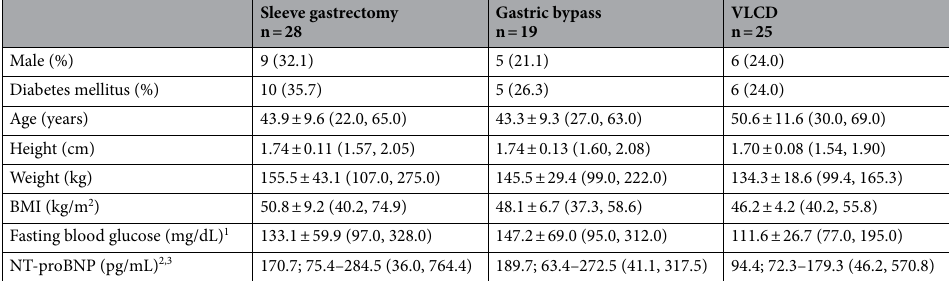
In the same 26-week period, NT-proBNP concentration increased by a median of 44.3 pg/mL from 170.7 pg/ mL (75.4–284.5) to 203.9 pg/mL (136.0–378.8) in the group receiving sleeve gastrectomy (p = 0.07, Fig. 1G), while it remained unchanged in the gastric bypass surgery and VLCD groups (both p ≥ 0.50, Fig. 1H,I). Similar results were obtained in sensitivity analyses when including individuals with a baseline NT-proBNP concentra- tion below the ELISA detection limit of 24.5 pg/mL (Supplemental Fig. 5a-c). In univariate correlation analyses, there were no associations between changes in weight, BMI, or fasting blood glucose and concomitant changes in NT-proBNP concentration after all three weight loss interventions (all p > 0.50). Exploratory analyses of NT‑proBNP determinants in a cross‑sectional study population. In exploratory analyses, we investigated determinants of NT-proBNP serum concentration in a larger population using data from the cross-sectional FoCus cohort to gain potential mechanistic insights. Characteristics of the FoCus cohort are shown in Table 2. Briefly, the cohort consisted of 387 individuals (72.9% females) without clinical diagnosis of heart failure. Mean age was 53.4 ± 11.7 years, mean BMI was 32.1 ± 12.0 kg/m 2 , and mean systolic/diastolic blood pressure were 129.0 ± 13.7 and 80.7 ± 7.5 mmHg, respectively. The cohort comprised non-diabetic individuals with normal fasting glucose (euglycemic, n = 218) as well as prediabetic (n = 108) and diabetic (n = 61) individuals. Accordingly, mean fasting glucose was 108.5 ± 39.6 mg/dL and ranged from 67.0 to 387.0 mg/dL. Median NT-proBNP was 8.5 (8.5–131.0) pg/mL and significantly higher in females compared to males (17.4 [8.5–153.1] pg/mL vs. 8.5 [8.5–50.7] pg/mL, p = 0.0003). Due to the skewed distribution of NT-proBNP values, participants were grouped into three categories based on their measured NT-proBNP value, representing 1) NT-proBNP concentration below assay detection limit of 25.4 pg/mL (n = 220), 2) low NT-proBNP concentration (n = 83 with median NT-proBNP of 66.6 [40.8–112.3] pg/mL), and 3) high NT-proBNP concentration (n = 84 with median NT-proBNP of 415.6 [244.8–851.3] pg/ mL, Fig. 2). Using these groups in statistical analyses, we found no association between NT-proBNP concentration and body weight (p trend = 0.21, Fig. 3A), BMI (p trend = 0.63, Fig. 3B), age (p trend = 0.08, Fig. 3C), and systolic blood pressure (p trend = 0.96, Fig. 3D). However, high NT-proBNP concentration was associated with less fat intake (p trend = 0.02, Fig. 4C) and less protein intake (p trend = 0.03, Fig. 4D). These results remained significant after further adjustment for BMI (both p ≤ 0.05). There was no trend for decreased carbohydrate and total energy intake with increasing NT-proBNP concentration (both p trend ≥ 0.10, Figs. 4A,B). There was no association between NT-proBNP serum concentration and fasting glucose serum concentration (p trend = 0.14). However, when grouping participants based on normal (< 100 mg/dL), prediabetic (between 100 and 126 mg/dL) and diabetic (> 126 mg/dL) fasting glucose, in euglycemic individuals, a higher NT-proBNP concentration was associated with lower fasting blood glucose (p trend = 0.005). In a between-group analysis, euglycemic individuals with high NT-proBNP values had a 3.1 mg/dL (CI: –5.6, –0.5, p = 0.01) lower fasting blood glucose compared to individuals with no detectable NT-proBNP (Fig. 5A). This association remained significant after further adjustment for BMI (p trend = 0.01). The association was not found in prediabetic or diabetic indi- viduals (both p trend > 0.8, Fig. 5B,C). There were no associations between NT-proBNP serum concentration and fasting insulin or HOMA-IR in the whole cohort (all p trend > 0.14) and in euglycemic, prediabetic, and diabetic subgroups (all p trend > 0.07). There was also no association between NT-proBNP concentration and measures of inflammation such as CRP, IL-6, and tryptophan (all p trend ≥ 0.30). For all presented results, sensitivity analyses were performed by using Spearman correlation analyses in the whole cohort and similar results were obtained (data not shown) except for tryptophan, were an inverse associa- tion has been found (r = –0.11, p = 0.03).